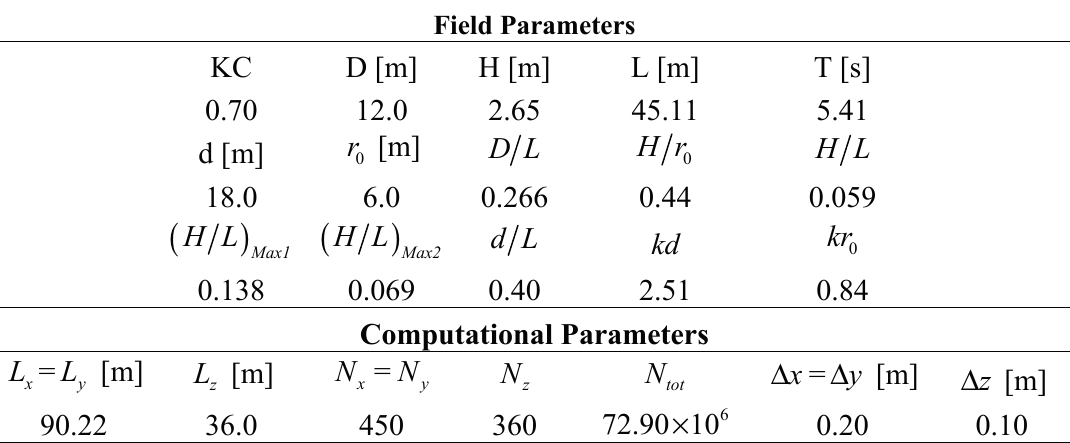
Table 2. Characteristic parameters used for the Euler wave-flow